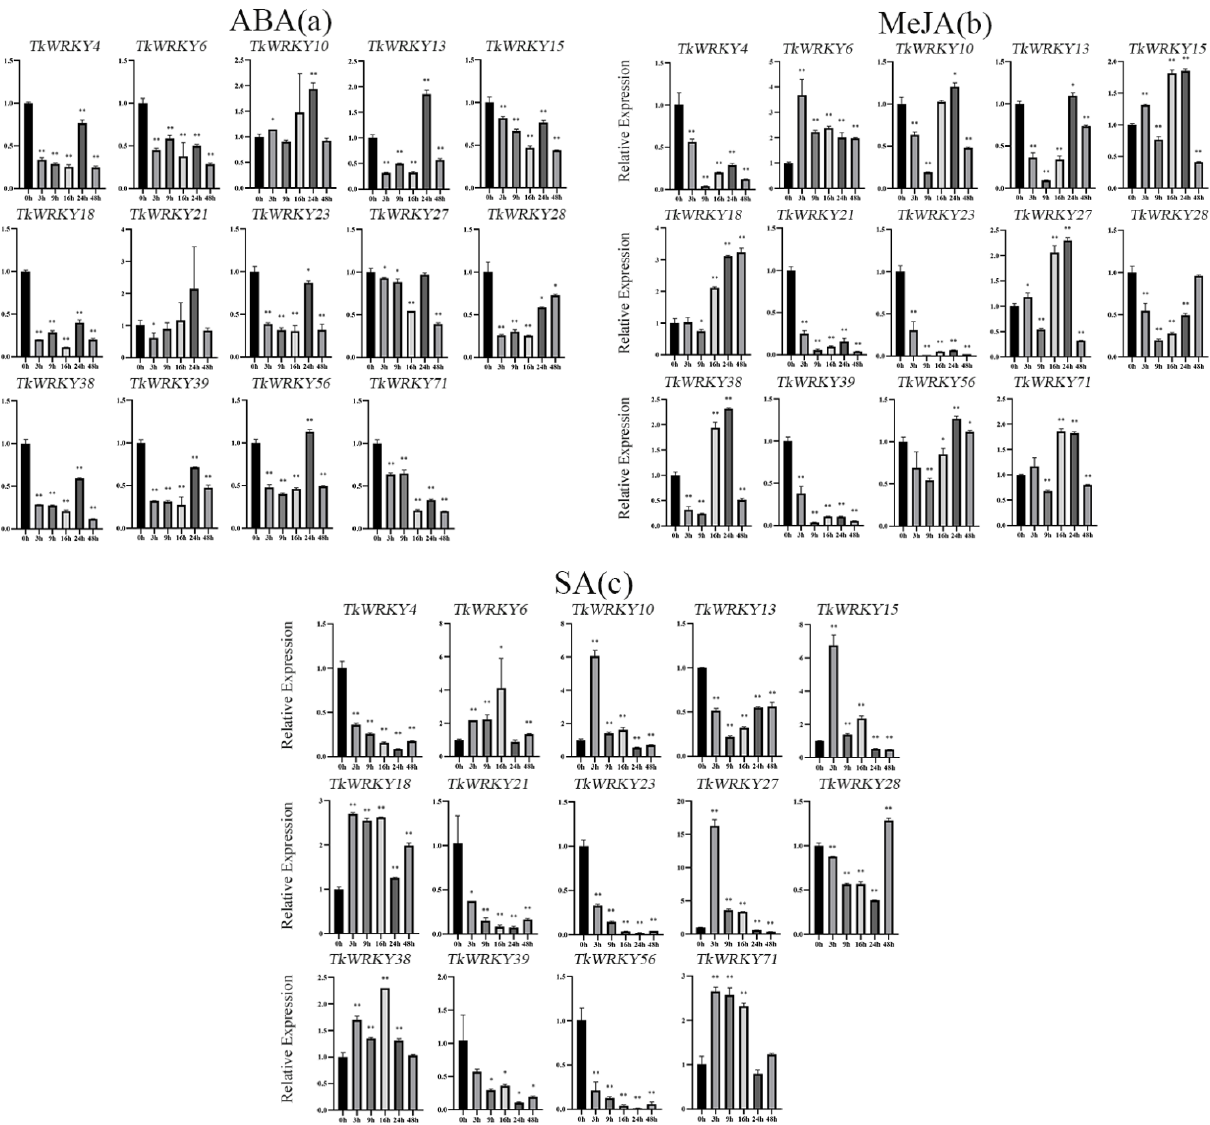
Figure 8. Modulation of gene expression of 14 TkWRKY genes at 0 (control), 3, 6, 9, 16, and 24 h after ( a ) cold, ( b ) heat, ( c ) salinity, and ( d ) osmotic stress. Data were normalized to β -actin and glycer- aldehyde-3-phosphate dehydrogenase ( GAPDH ). Vertical bars indicate the standard deviation whereas an asterisk indicates the summary of the p value of the independent sample T-test of the corresponding gene compared with the control (* p < 0.05, ** p < 0.01).